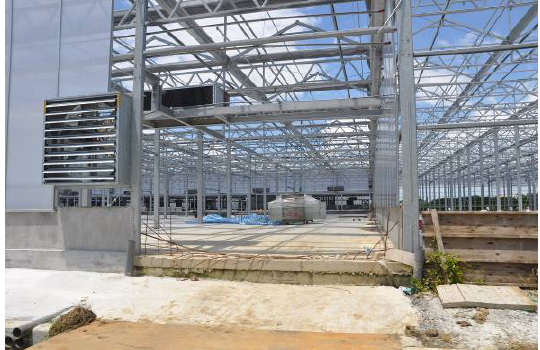
Figure 9. An orchid greenhouse with a concrete